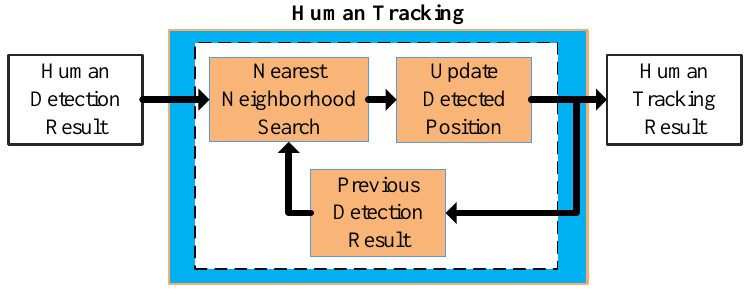
Figure 3. Block diagram of human tracking process.